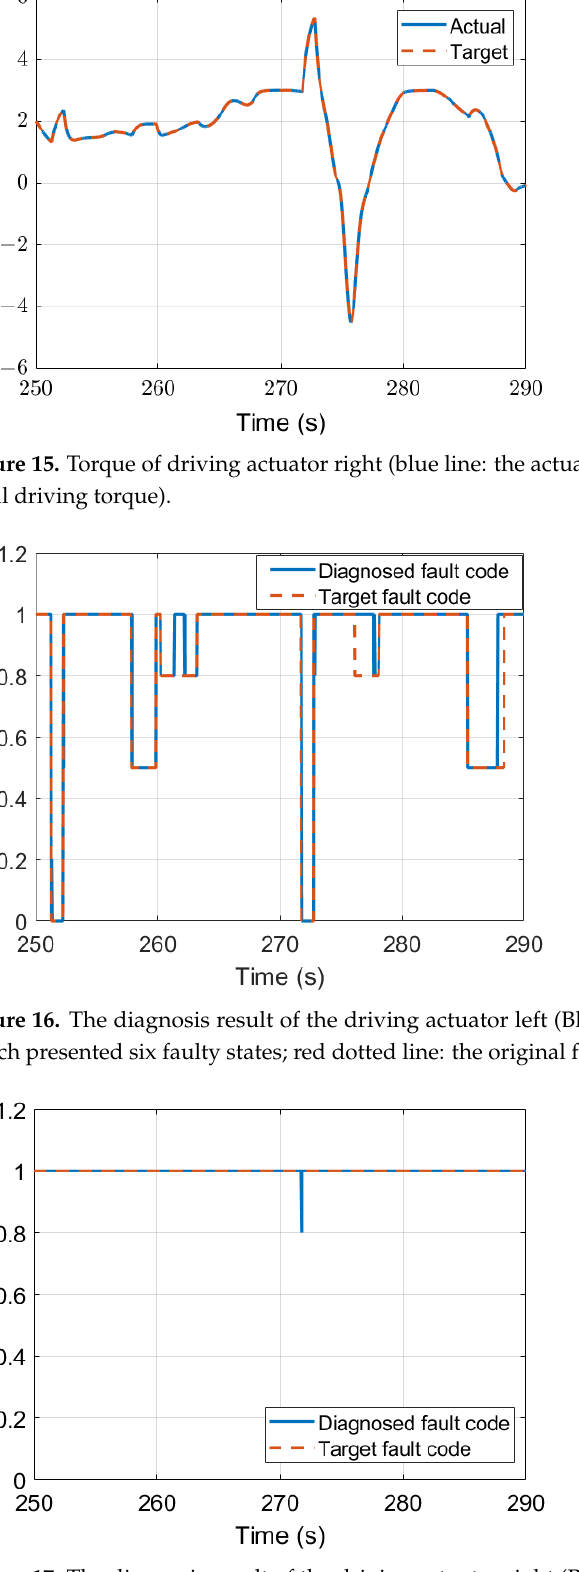
Figure 17. The diagnosis result of the driving actuator right (Blue line: the actual diagnosis results, which presented no fault of driving actuator right; red dotted line: the original fault